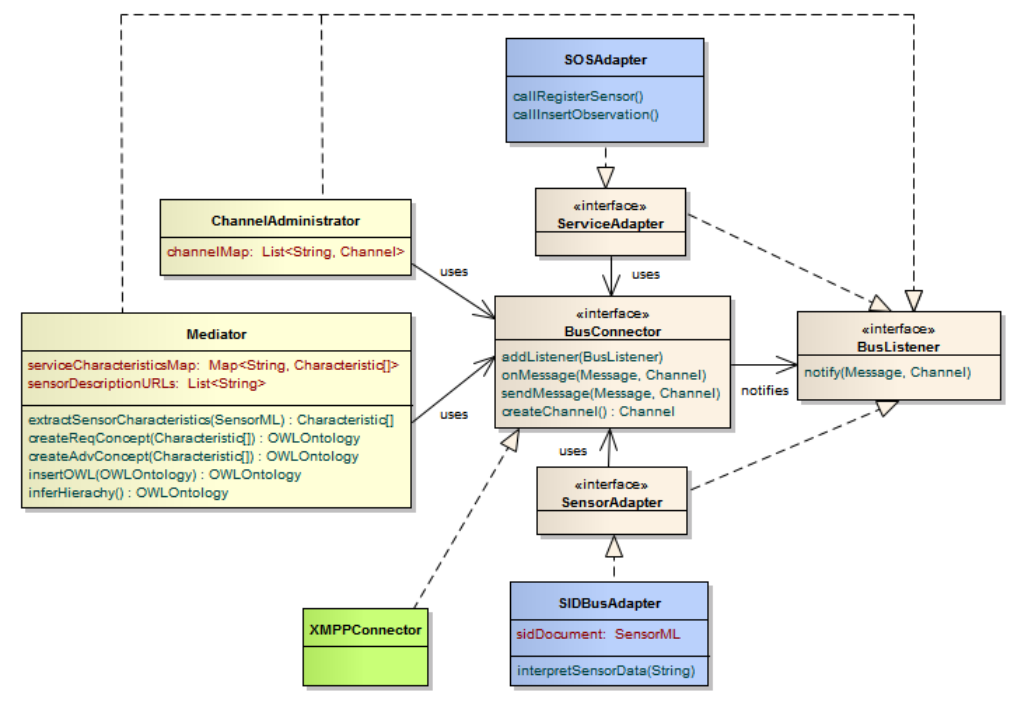
Figure 9. Overview of the class hierarchy of the Sensor Bus implementation.